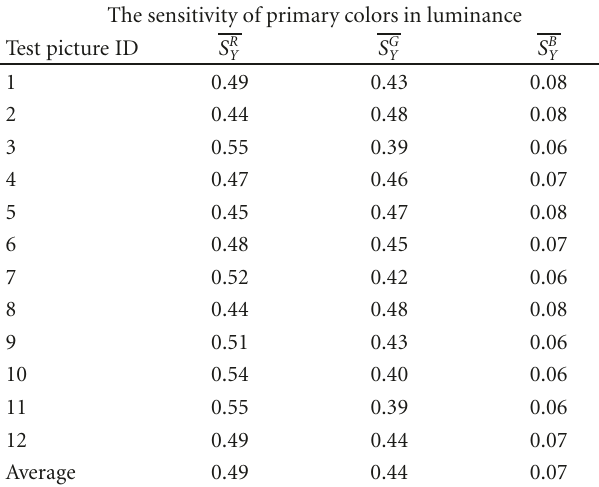
Table 3: The analysis of average sensitivities.